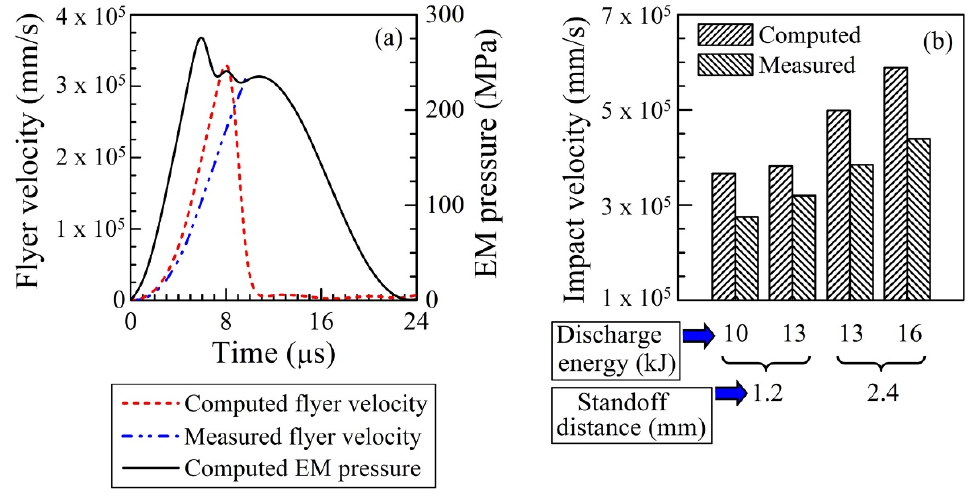
Figure 6. ( a ) Computed EM pressure and computed and measured flyer velocity for a duration of 24 µs. Process conditions: O-shaped coil, applied energy = 13 kJ, standoff distance = 1.2 mm. ( b ) Impact velocity of flyer for multiple standoff distance and applied energy combinations.